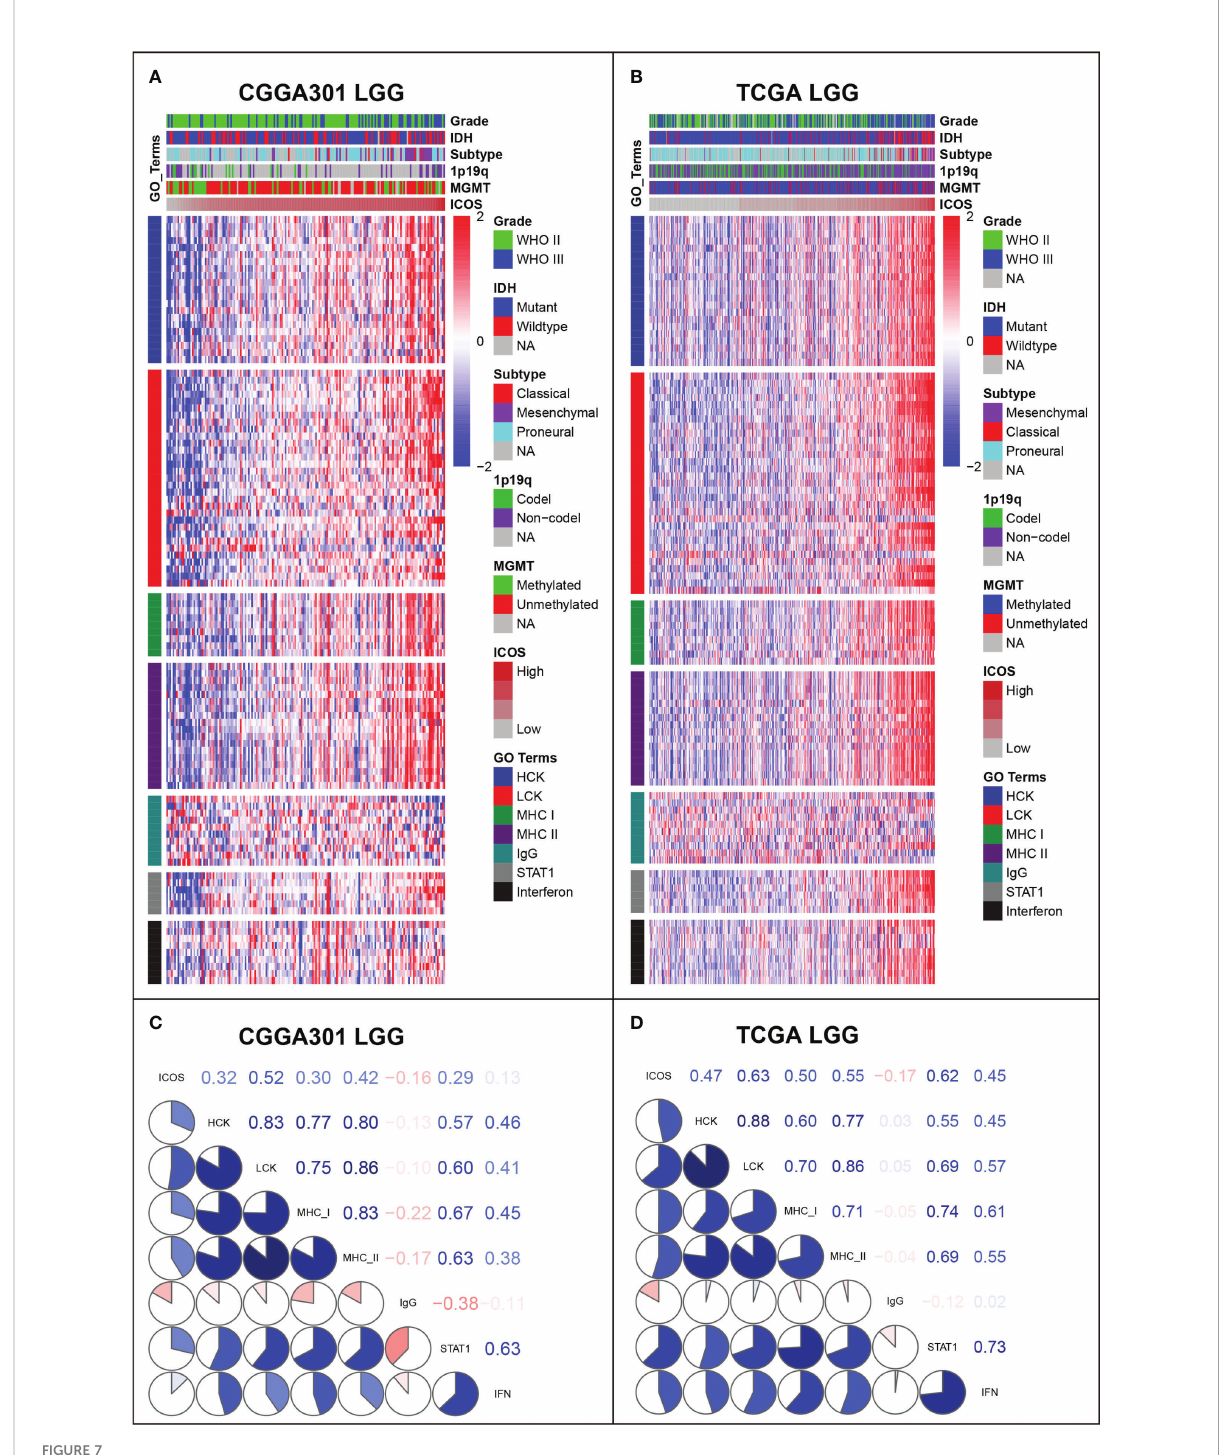
FIGURE 7 G e ne Set Variation Analysis (GSVA) of ICOS-related in fl ammatory activities of lower-grade glioma in CGGA301 and TCGA datasets. (A) Heatmap of representative genes from different in fl ammatory activities in CGGA301 lower-grade glioma. (B) Heatmap of representative genes from different in fl ammatory activities in TCGA lower-grade glioma. (C) Intercorrelation between ICOS and seven metagenes in CGGA301 lower-grade glioma. (D) Intercorrelation between ICOS and seven metagenes in TCGA lower-grade